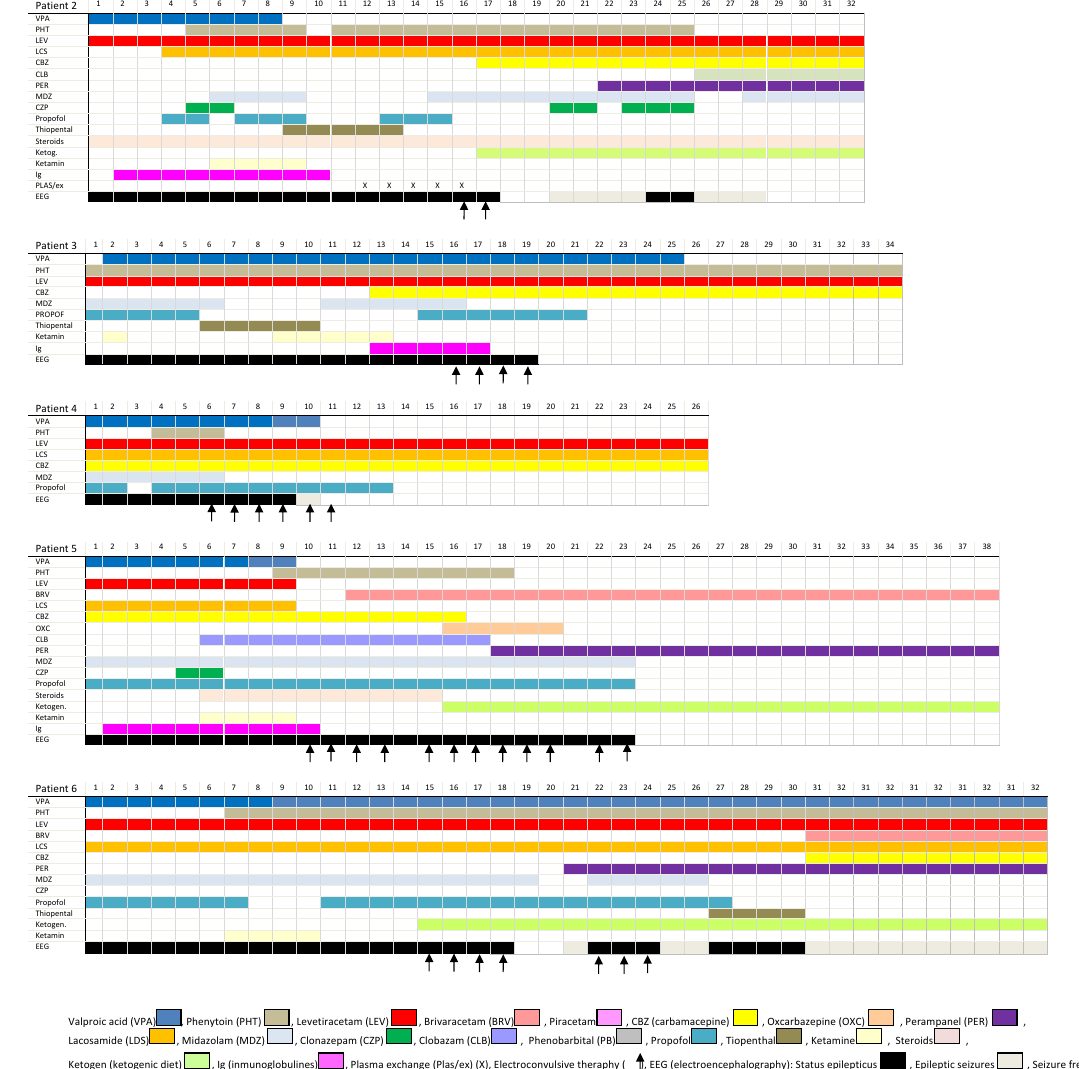
Figure 1. Treatments of each patient from accepting in ICU or 15 days before the first ECT after the last